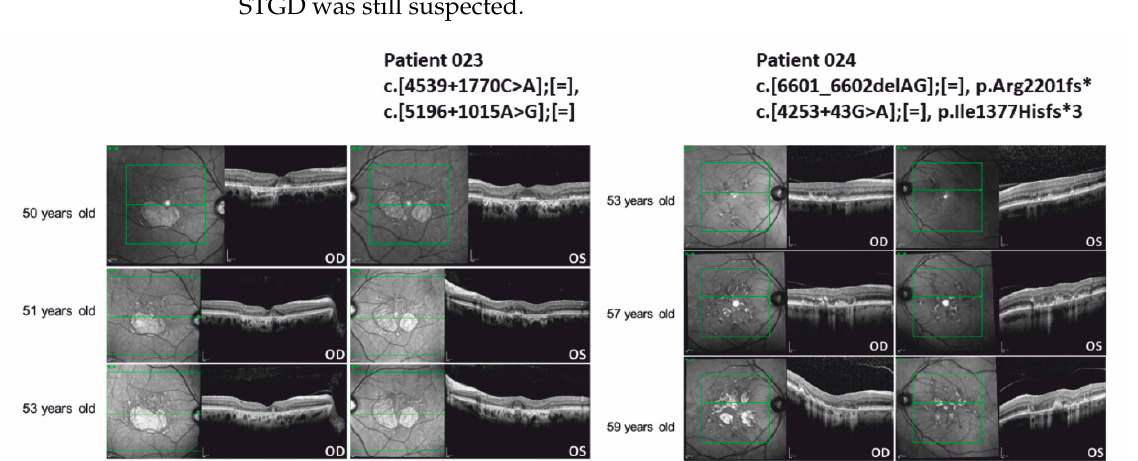
Figure 4. Optical coherence tomography (OCT) images of the macular region of patient 023 and 024 carrying ABCA4 deep-intronic variants. Genetic nomenclature of the variants identified in ABCA4 is shown above the OCT images. OD: oculus dexter, right eye. OS: oculus sinister, left eye.